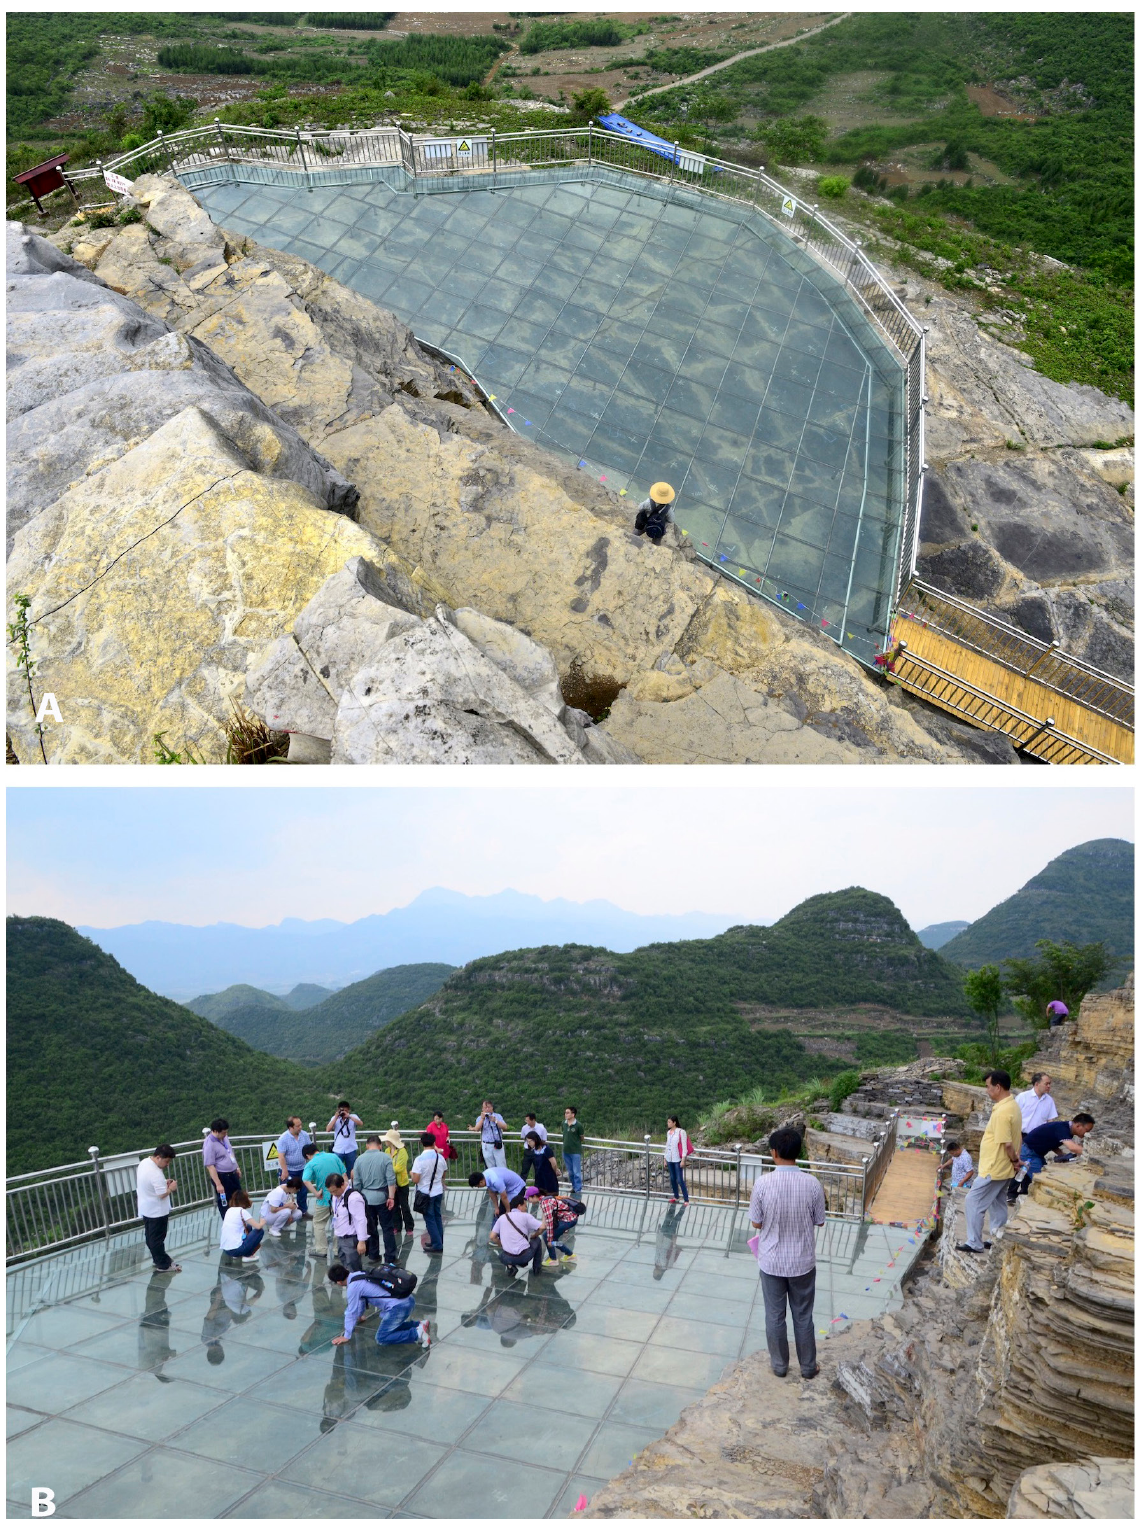
Figure 11. Viewing area for the Dikoposichnus nothosaur tracks. The whole site was covered with thick glass sheets, and a safety fence installed, so visitors can examine the fossils close up. Photographs by